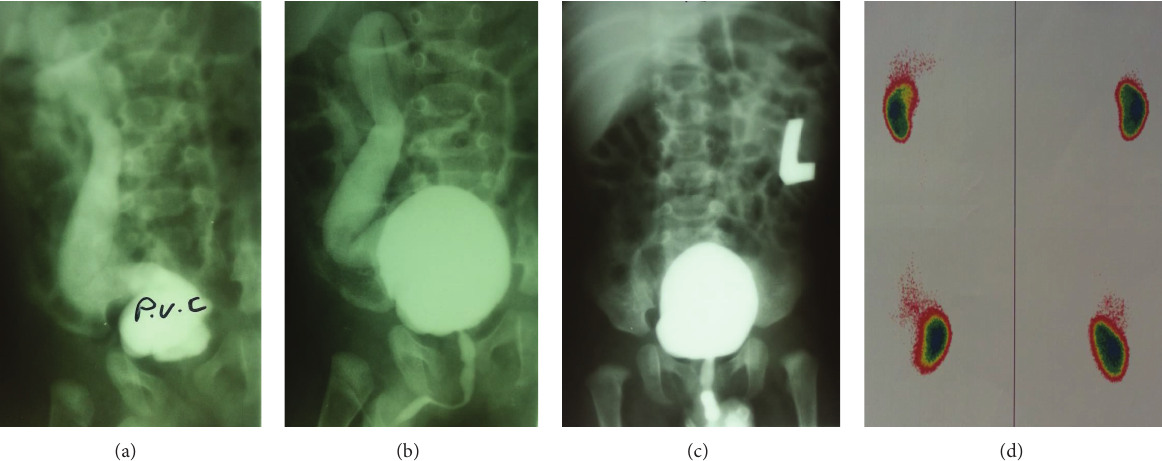
Figure 2: AP and oblique view VCUG showing left to right renal ectopia and high-grade left sided VUR that persisted after first valve ablation ((a), (b)) and resolution of VUR after second valve ablation (c). DMSA renal scan shows proper cortical function of the right kidney and nonvisualization of the left kidney